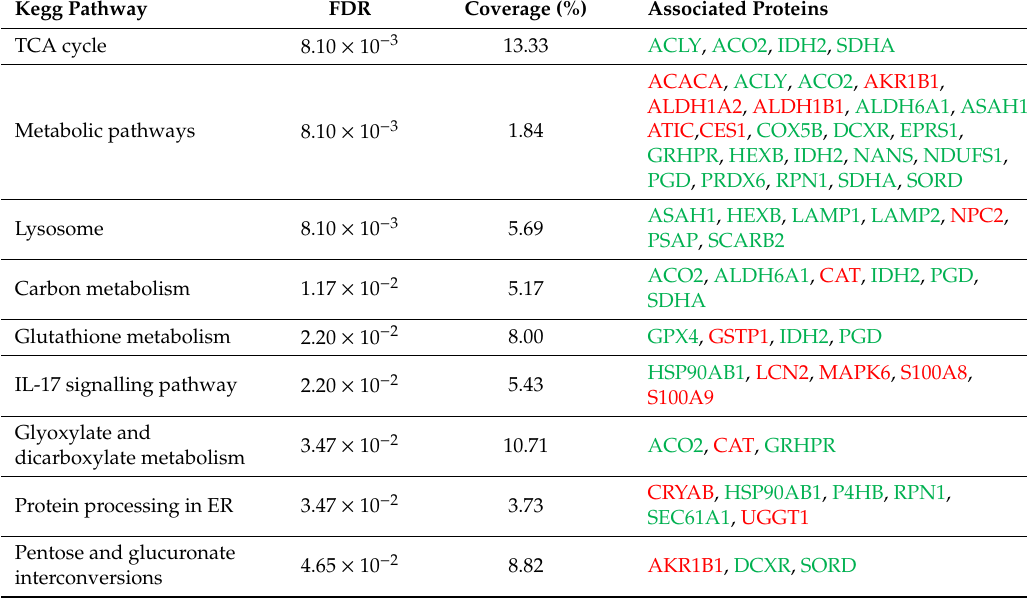
Table 1. Pathway enrichment analysis: List of significantly enriched pathways (false discovery rate (FDR) < 0.05).